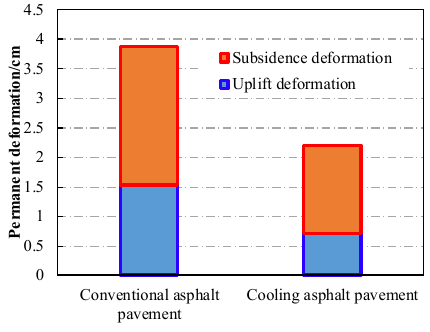
Figure 14. Rutting deformations of two different asphalt pavement structures.